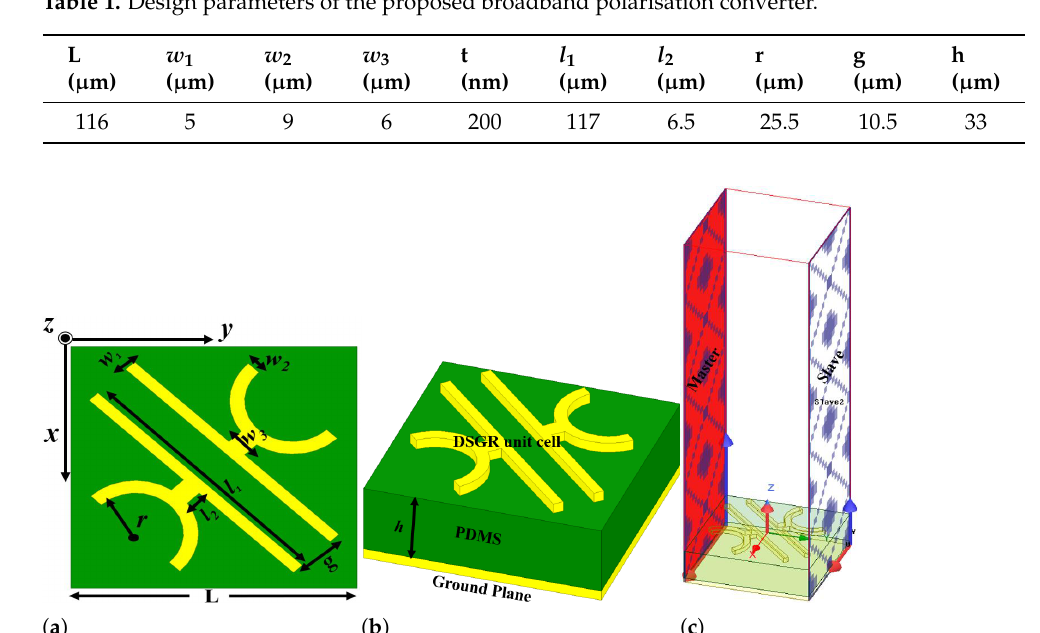
Figure 1. Schematic of the proposed converter ( a ) 3D view ( b ) front view ( c ) HFSS simulation setup of the PC.